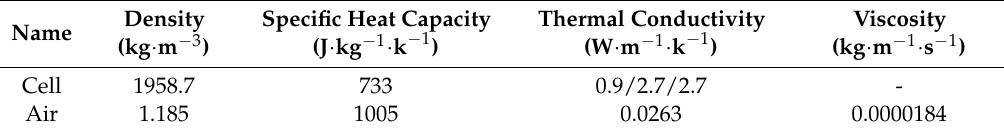
Table 2. Thermophysical parameters